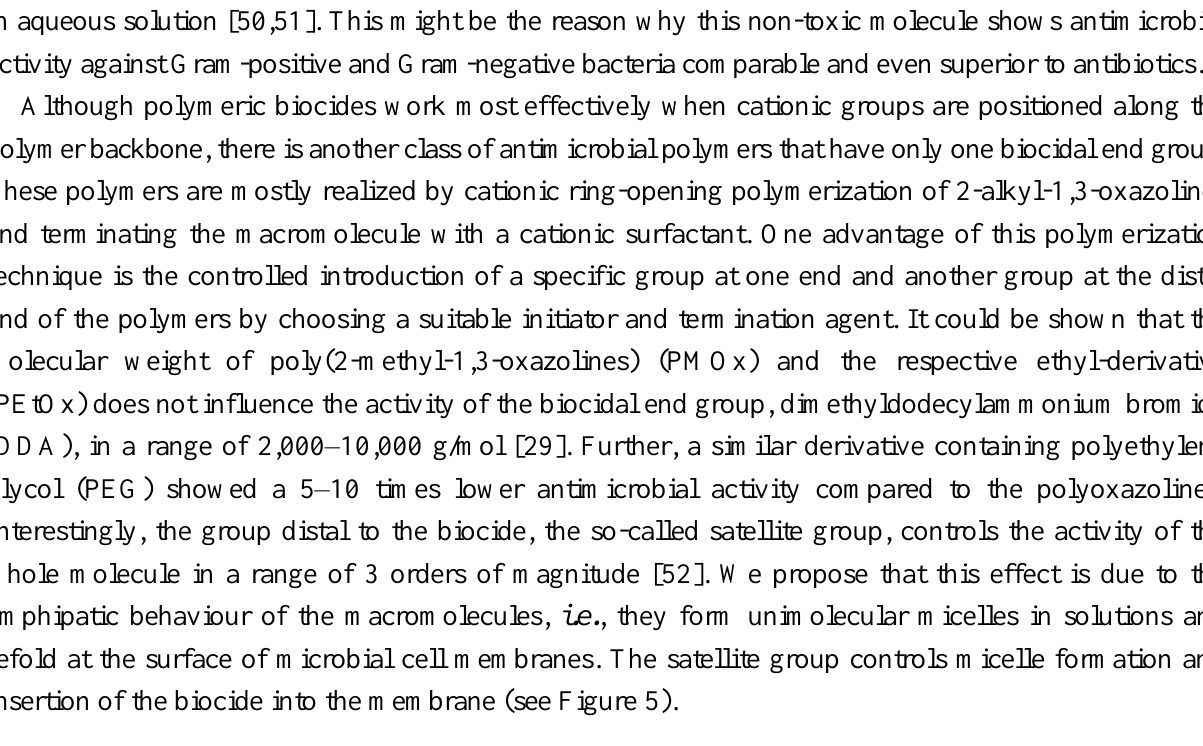
Figure 5. Working concepts of telechelic poly(2-alkyl-1,3-oxazolines) with antimicrobial end group and satellite group. Redrawn according to